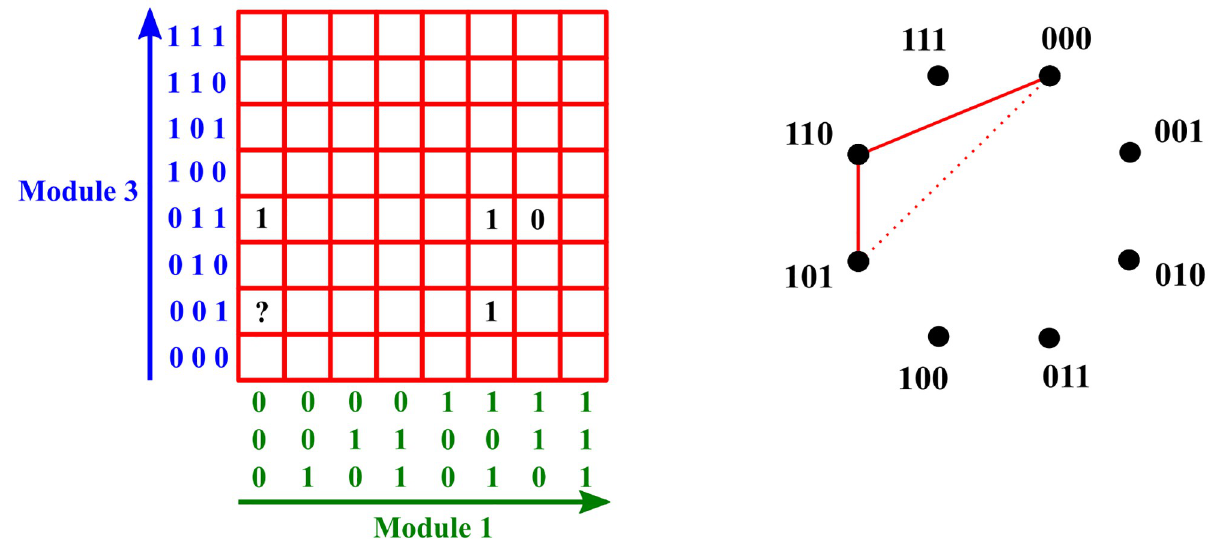
Fig 4. Schematic representation of the Label determination procedure. The left figure shows an intersection of a hyperplane of constant inputs, say 0, 0, 0, for Module 2 with the orthotope of the network of Fig 1 (i.e., a “red slice”). The right figure represents the related conflict graph for Module 1. In accordance with K ő nig’s theorem, adding the dashed line to the edge set breaks the bipartiteness of the graph. Since assigning label 0 to the input vector (0, 0, 0, 0, 0, 0, 0, 0, 1) would imply the existence of an edge between (0, 0, 0) and (1, 0, 1) in the conflict graph, the label for the ‘?’ cell must be